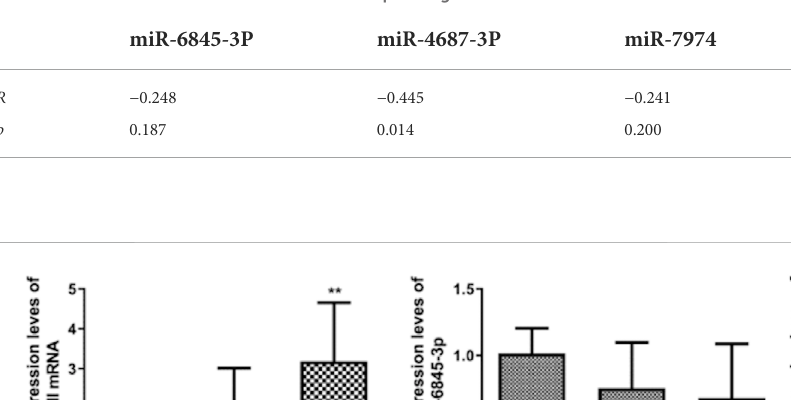
TABLE 7 Correlation between AT-III and corresponding miRNA.